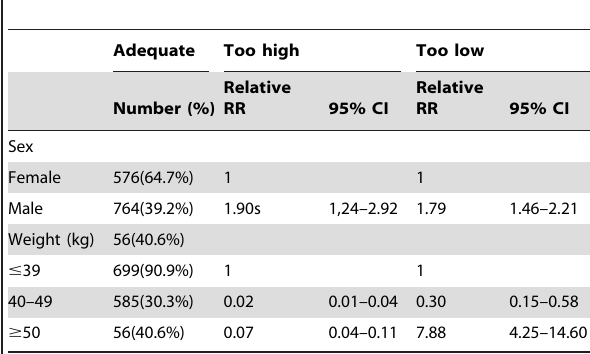
Table 5. Factors associated with inadequate dosing of ethambutol, 2007–2010,